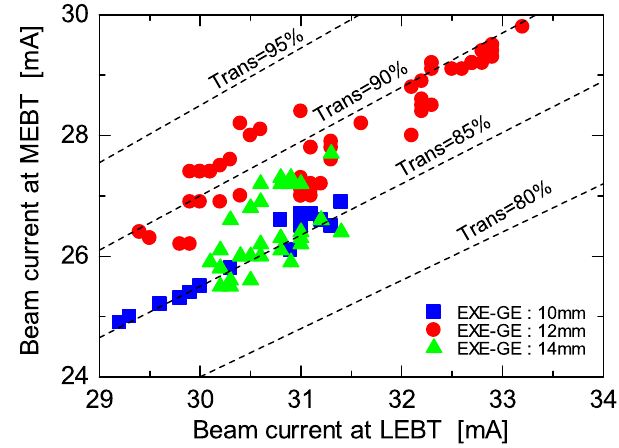
FIG. 7. (Color) Relationship between beam current at MEBT and LEBT for different acceleration gap lengths.